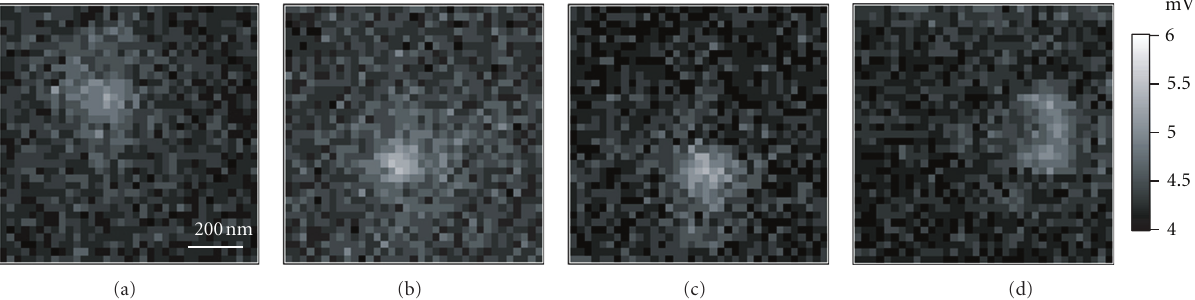
Figure 6: Scattering images of the p -polarization laser focus measured by the probes with di ff erent silver coatings. The images (a)–(d) correspond to the probes shown in Figures 4(a)–4(d),